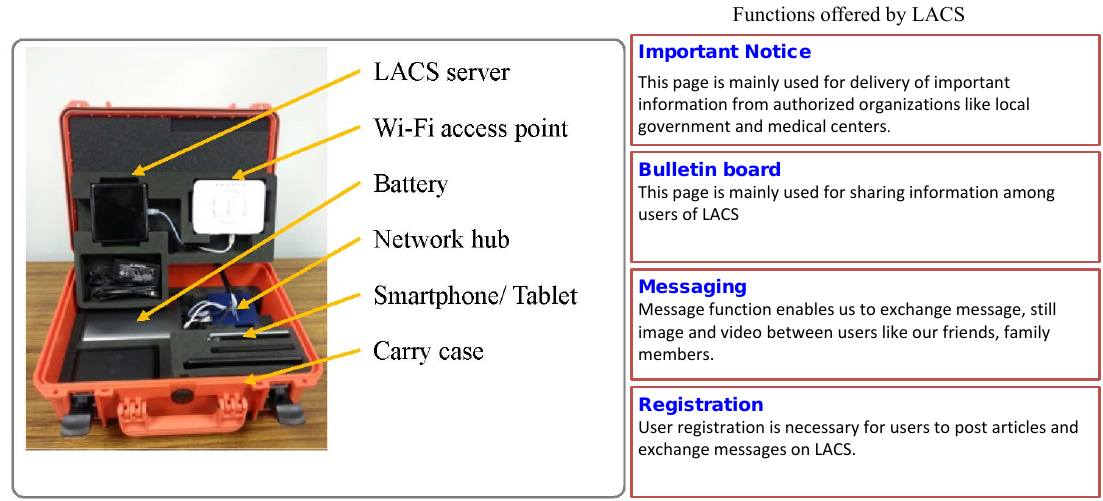
Figure 2. LACS structure